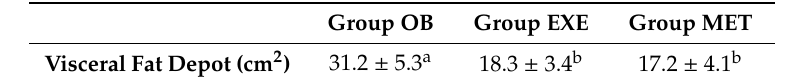
Figure 1. Changes over time in the mean values ( ± S.E.M.) for body mass (left hand) and subcutaneous fat depth (right hand) in gilts confined and fed ad libitum with obesogenic diets (group OB, black bar) and gilts with opportunity of exercise and controlled non-obesogenic diets without or with metformin (groups EXE and MET, grey and white bars, respectively). Significant di ff erences are denoted by di ff erent superscript letters among treatments (a (cid:44) b: p < 0.001; c (cid:44) d: p < 0.005; e (cid:44) f: p < 0.05). Table 1. Mean values ( ± S.E.M.) for visceral fat depots in gilts with opportunity of exercise and controlled non-obesogenic diets, treated or not with metformin (groups EXE and MET, respectively) and gilts confined and fed ad libitum with obesogenic diets (group OB).